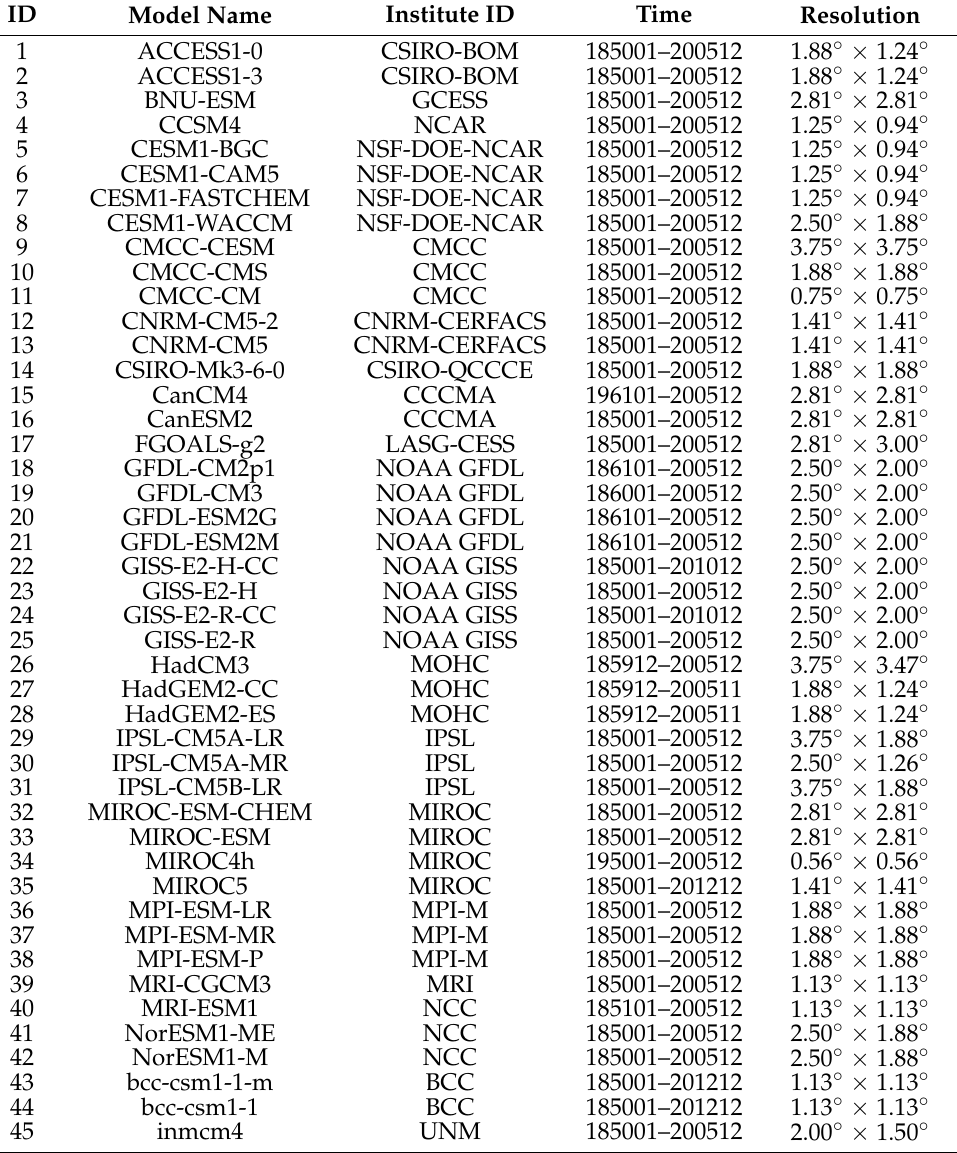
Table 1. Detailed information on the 5th phase of the Coupled Model Intercomparison Project (CMIP5) general circulation models (GCMs) used in this